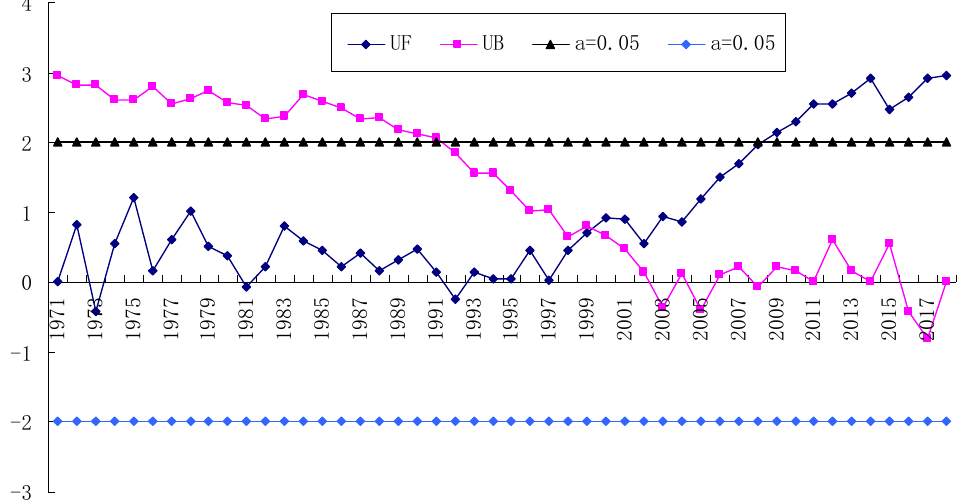
Figure 4. Trends of annual precipitation changes during the summer and autumn seasons in Fujian from 1971 to 2018.